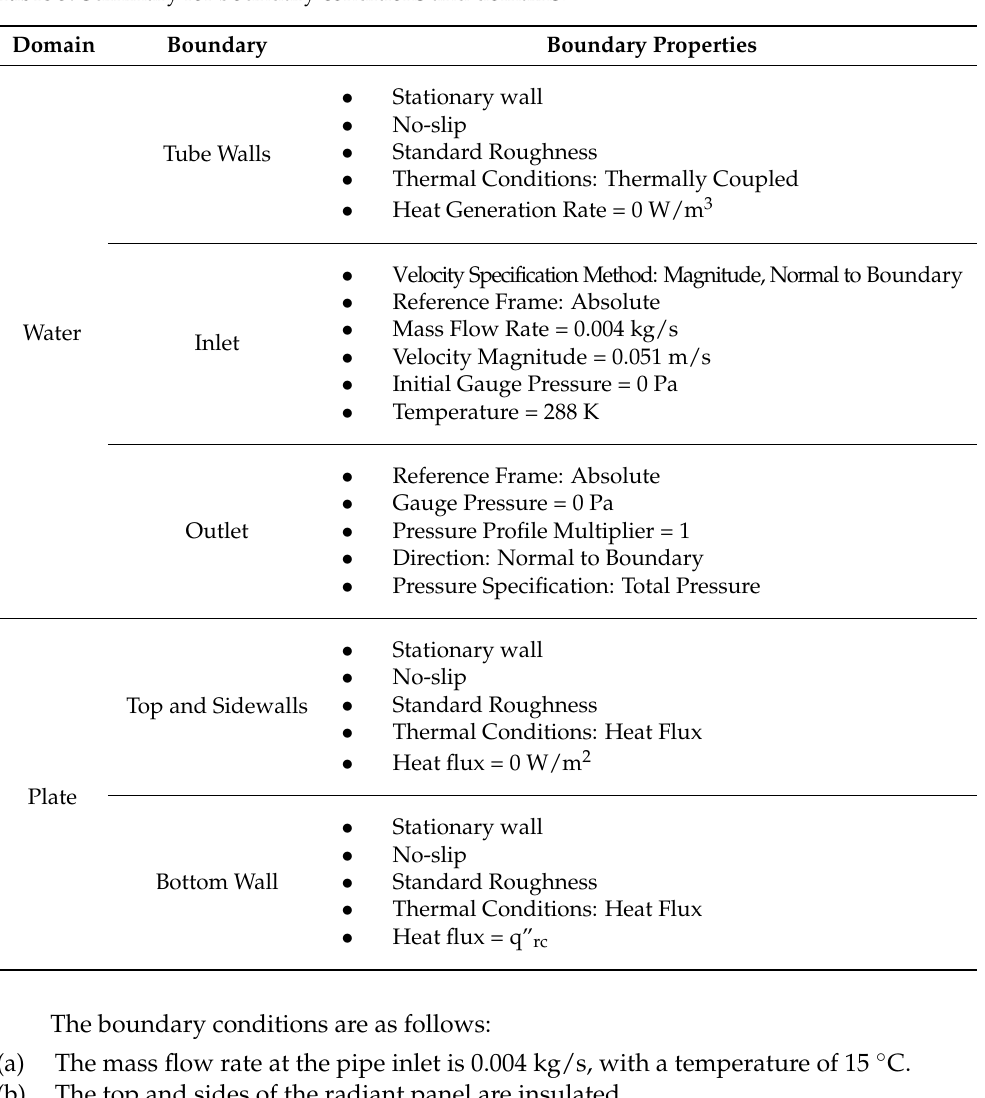
Table 3. Summary for boundary conditions and